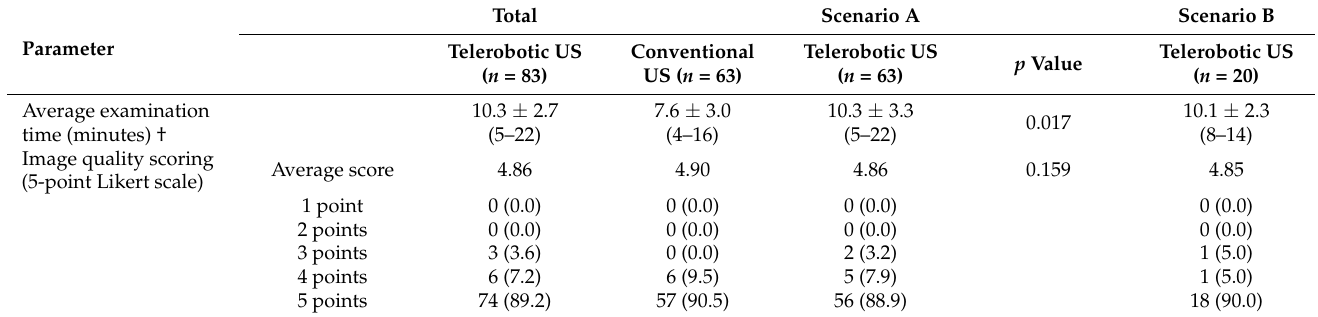
Table 3. Quality scoring of 5G-based telerobotic US images and conventional US images. Except were indicated, data in parentheses are percentages. †: The data are expressed as means ± standard deviation, with ranges in parentheses. Abbreviations: US: ultrasound.